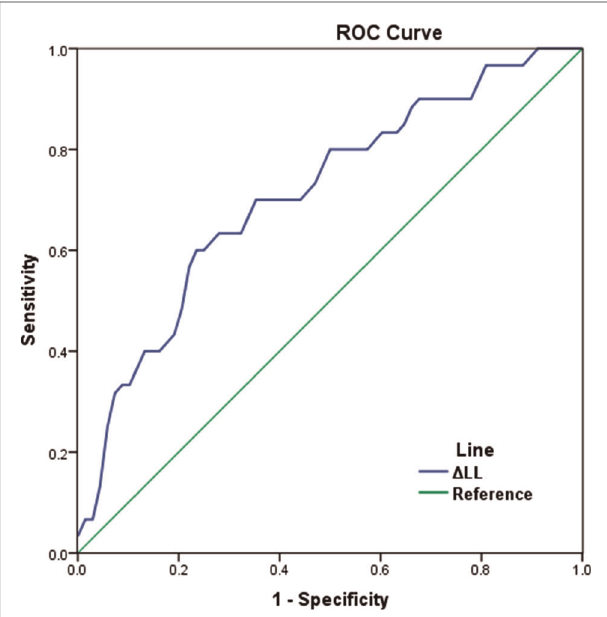
FIGURE 2 | ROC curve showing the performance of Δ LL in predicting mechanical complications (the area under curve (AUC) was 0.721, the optimal cut-off value of Δ LL was 9.8°). Δ LL: the absolute value of the gap between actual LL and ideal